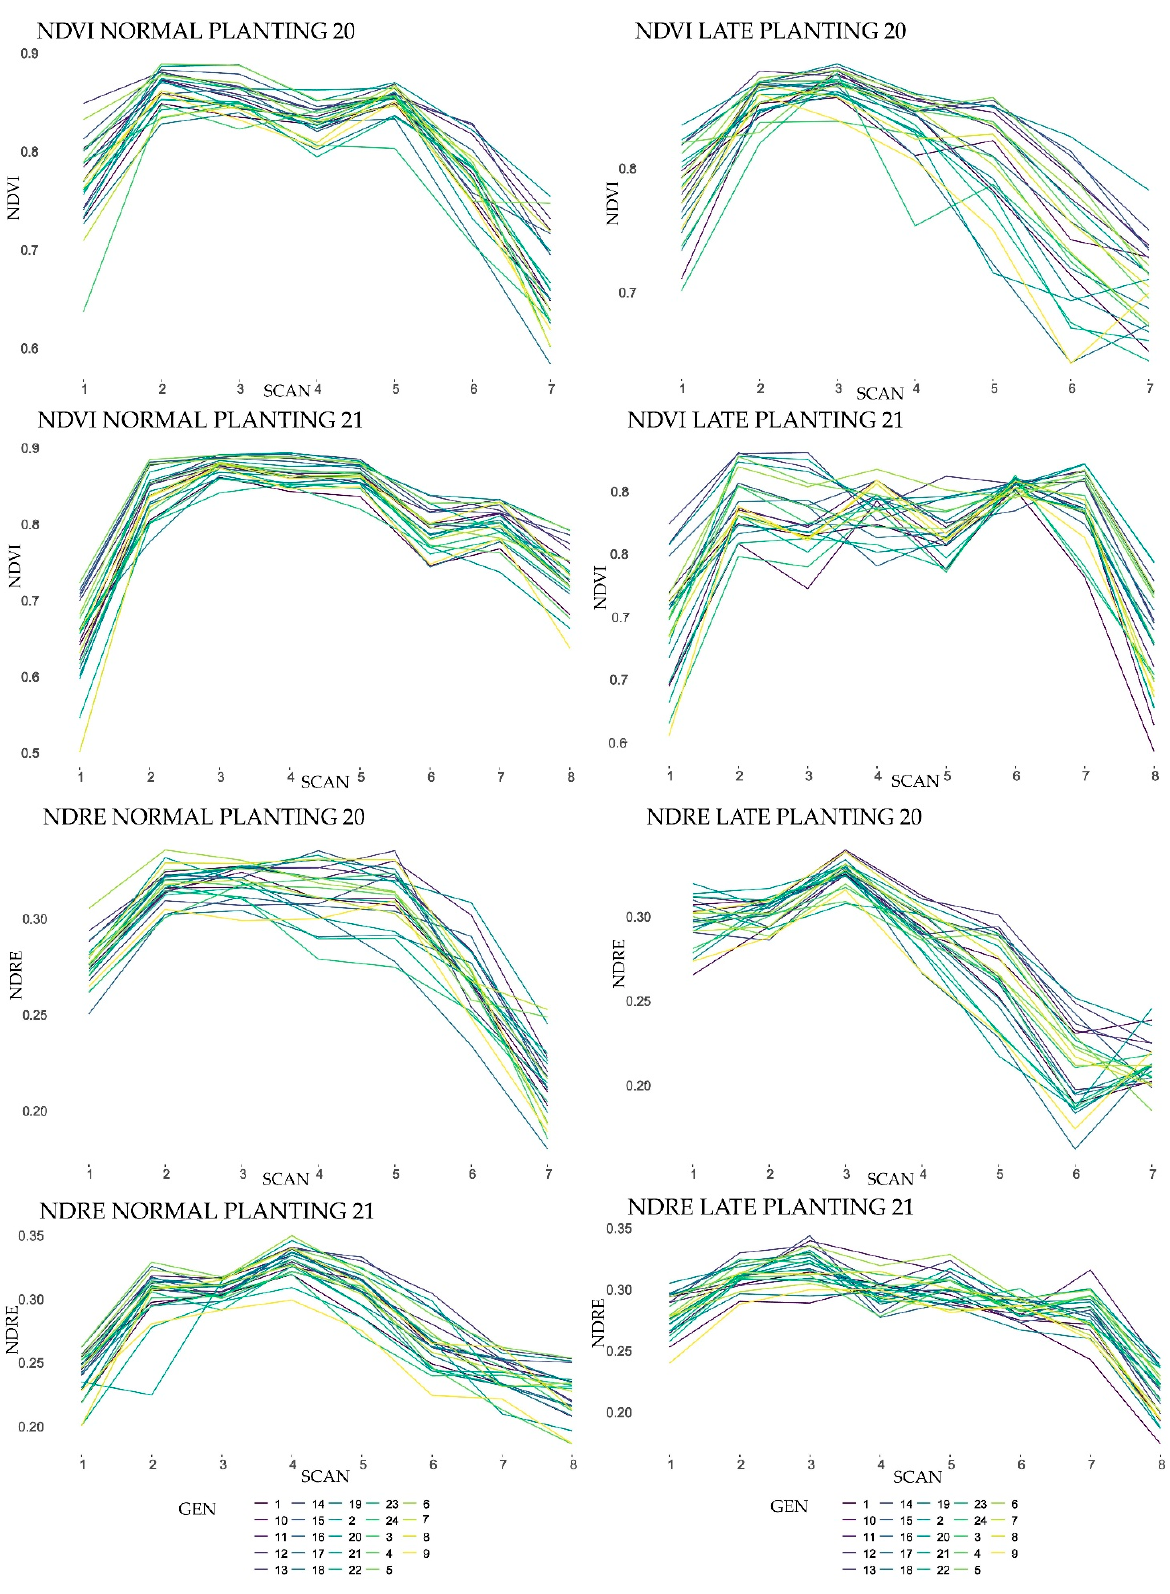
Figure 5. Line graphs from field phenotyping. NDVI and NDRE values of sesame lines and landraces (GEN) for both growing conditions and cropping years monitored by Crop Circle ACS-430 active canopy sensor. (x axis = number of scans, y axis = SRI values for each genotype). NDVI values ranged from 0.424 to 0.902 with an all-genotypes average of 0.782. A common pattern of NDVI evolution was observed for almost all of the genotypes. NDVI had the lowest value at the first scan (51 DAP) in the beginning of the reproductive stage, reaching the maximum values at 2, 3, 4 scans followed by a progressive decline in accord- ance with the maturity of the crop. From scan 1 to 2 when also the in-season N fertilization occurred, the NDVI average values for all genotypes increased from 0.75 to 0.85 (approx- imately by 13%). NDVI values remained almost in variable for scans 2 to 5 until the crop entered ripening stage. For NP21, the NDVI raise from scan 1 to 2 was from 0.65 to 0.85. Similar patterns were observed for the NDRE. Its values ranged from 0.130 to 0.360 with an all-genotypes average of 0.267. From scan 1 to 2 NDRE average values for all gen- otypes increased from 0.28 to 0.31 (approximately by 10%) except NP21 when as in the case of NDVI average values showed a steep raise. The decline was rapid for both indices, but for NDRE, it started earlier when the crop was still in the reproductive stage. (Figure 4). Variation between sesame lines was greater for both indices in LP20 and NP21. NDVI varied significantly between genotypes for every monitoring date in both growing condi- tions and cropping years and almost the same was observed for NDRE, except scans 1 and 6 on NP20 and scan 9 on LP20. Both NDVI and NDRE enabled distinction between geno- types but in most cases NDVI provided better separation, as shown at four monitoring dates during crop growth (Tables 4–6). Even in the middle of the reproductive growth stage when crop canopy is closed (NDVI3, LP21 and NDRE3, LP21) SRI values produced a clear genotype separation (Figure 6, genotypes with different letter and color are signif- icant different). Line 2 gave the higher NDRE and NDVI values (mean values from both planting dates and years) 0.282 and 0.822, respectively, lines 1 and 9 had the lowest values (0.250 and 0.750), respectively. Early maturing lines and landraces always had low NDVI, but NDRE produced mixed results and even late maturing lines exhibited low values.